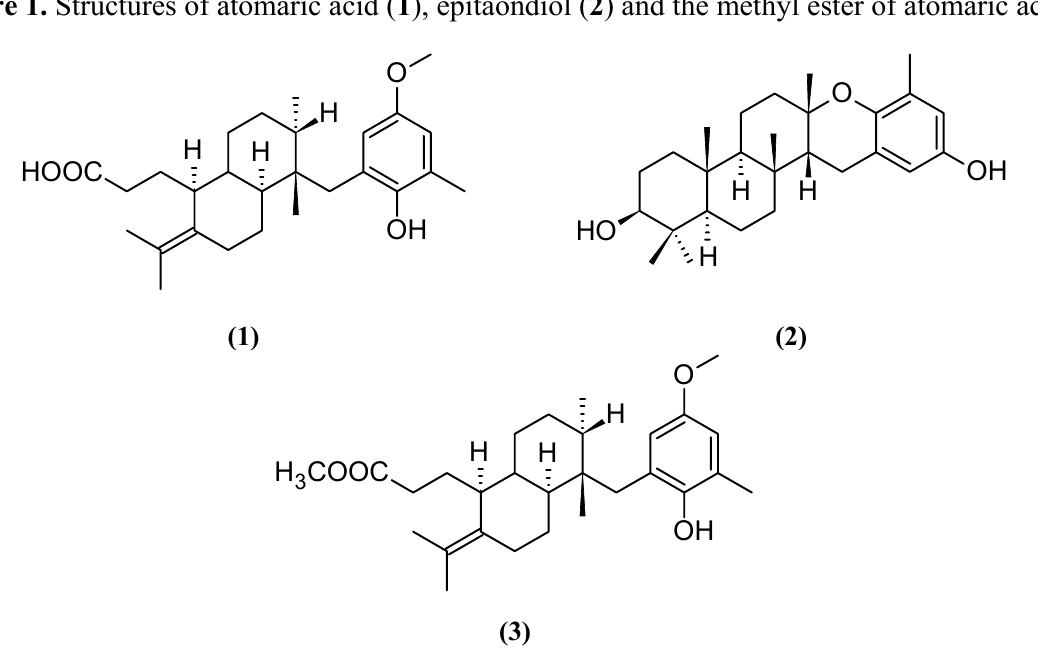
Figure 1. Structures of atomaric acid ( 1 ), epitaondiol ( 2 ) and the methyl ester of atomaric acid 3